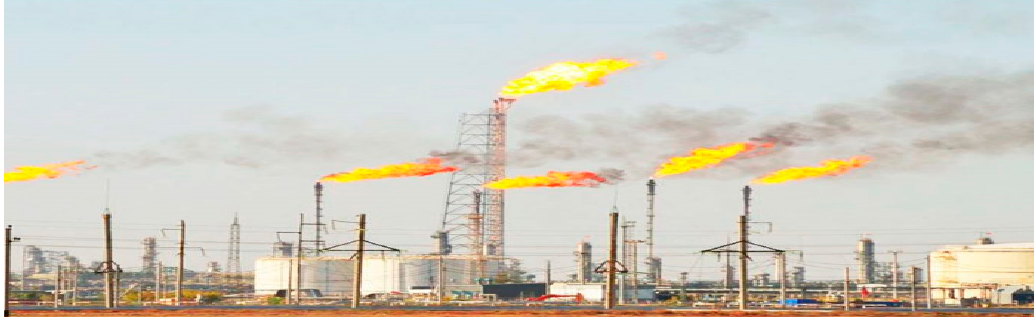
Figure 1. Gas Flaring in Nigeria’s Upstream Petroleum Sector. Source: Nigeria’s New Gas Flare Agenda 2019, available at: This Day online Newspaper, https: // www.thisdaylive.com / index.php / 2019 / 04 / 16 / nigerias-new-gas-flare-agenda / (accessed 16 September 2019).